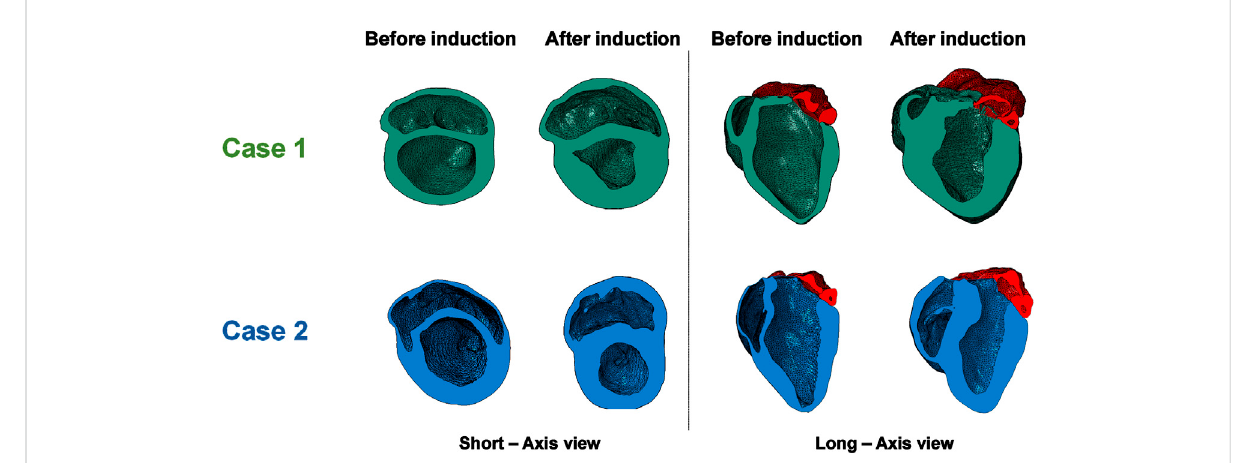
FIGURE 3 Long and short axis views of the two cases before and after HFpEF induction.